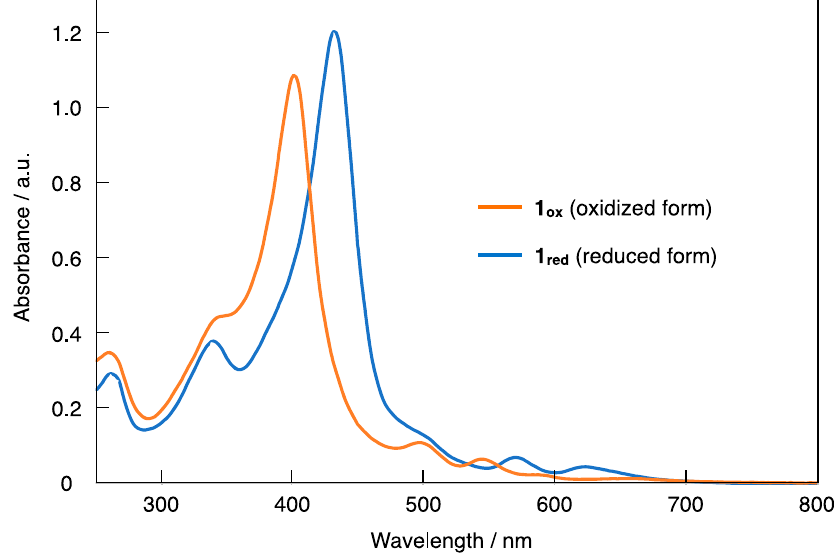
Figure 4. Comparison of UV–VIS spectra of 1 red and 1 ox